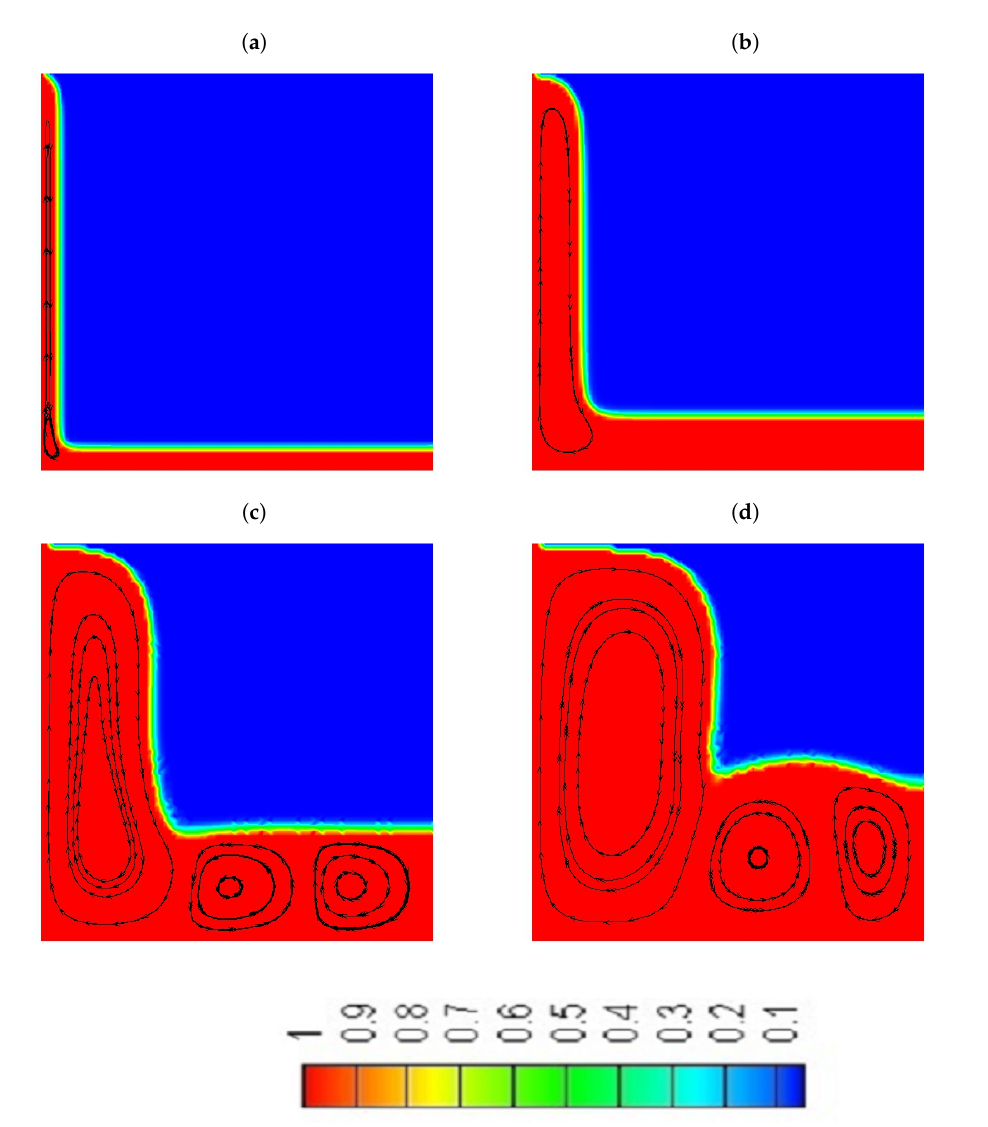
Figure 4. The evolution of solid-liquid interface profiles for the case of φ w = 10%. ( a ) t = 1 s, ( b ) t = 2 s, ( c ) t = 25 s, ( d ) t = 50